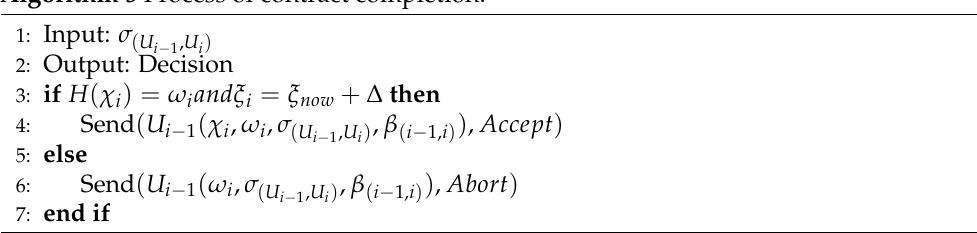
Algorithm 5 Process of contract